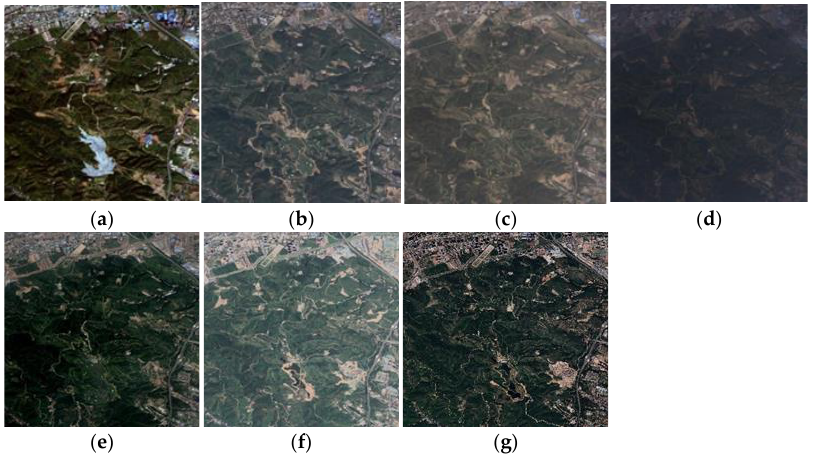
Figure 2. Remote sensing image of the study area. ( a ) 22 September 2010; ( b ) 17 August 2013; ( c ) 16 August 2015; ( d ) 15 September 2016; ( e ) 20 August 2017; ( f ) 20 July 2020; ( g ) 21 June 2021.